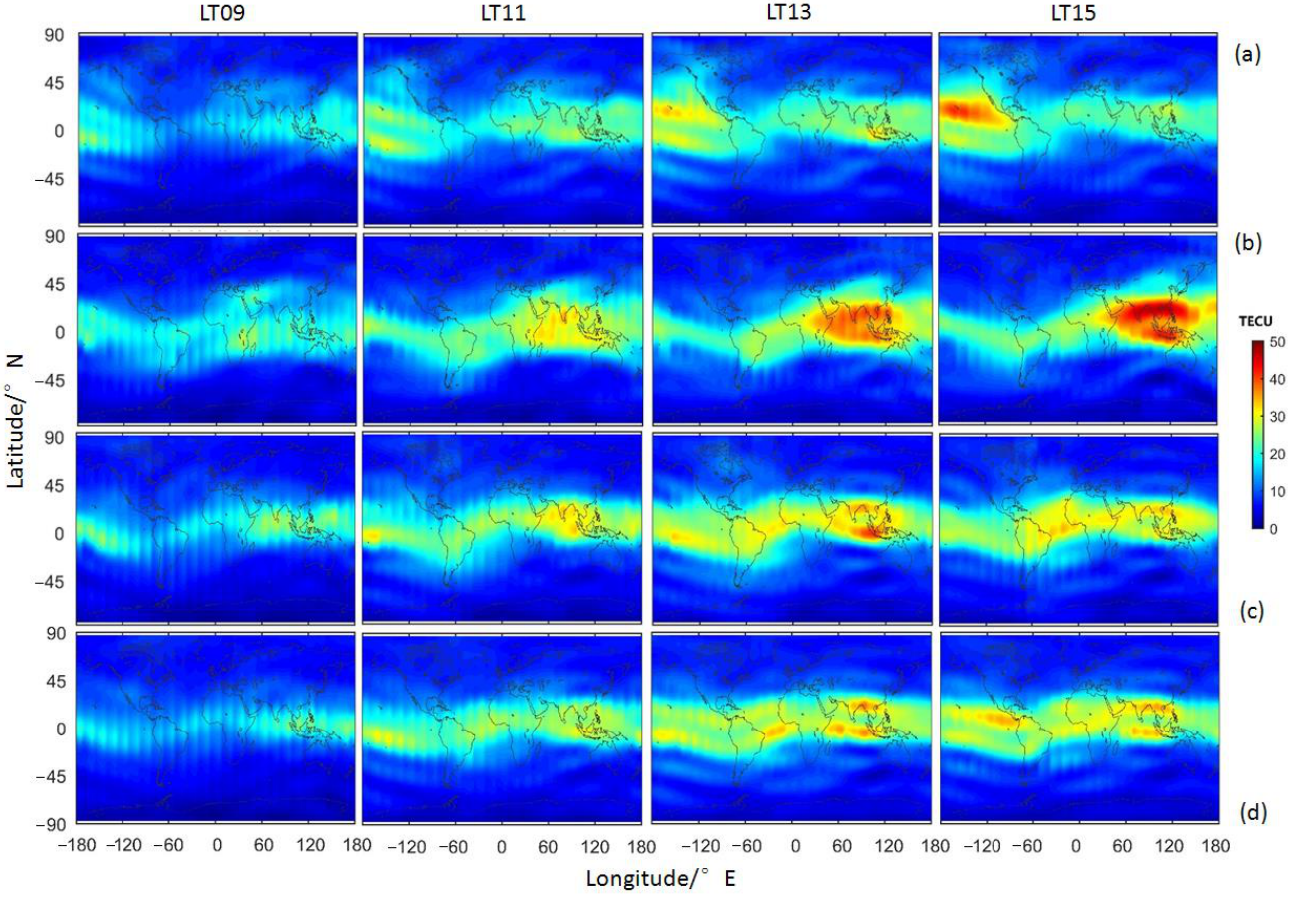
Figure 8. The global TEC mapping at local time 09:00 to 15:00 during 25–28 August in 2018 (( a )–( d ) represents 25–28 August, respectively).